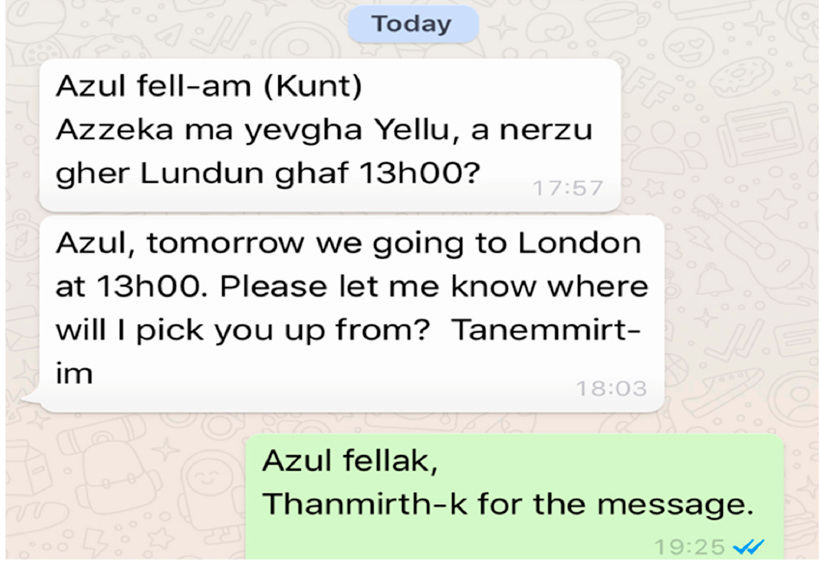
Figure 1. Anazar’s message in Kabyle.